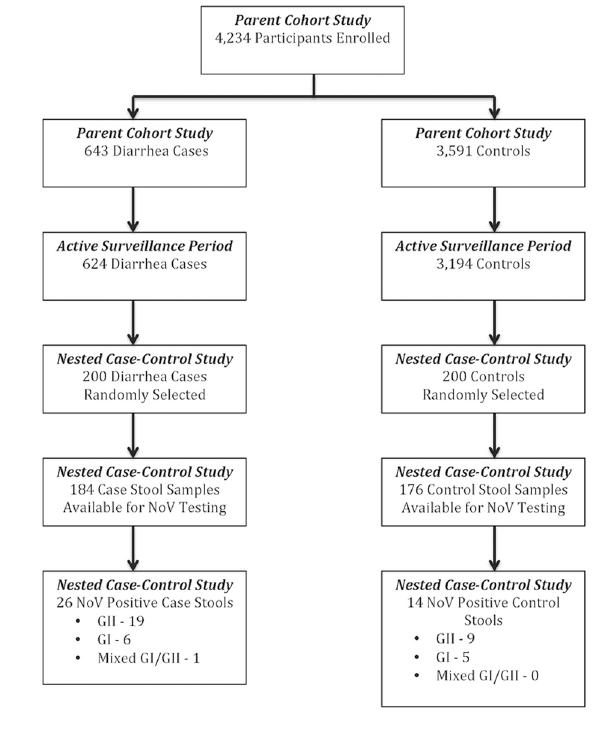
Fig 2. Flow diagram of participant enrollment, diarrhea outcomes, and selection for nested case- control study. Abbreviations: NoV = norovirus; GI = Norovirus genogroup I; GII = Norovirus genogroup II.